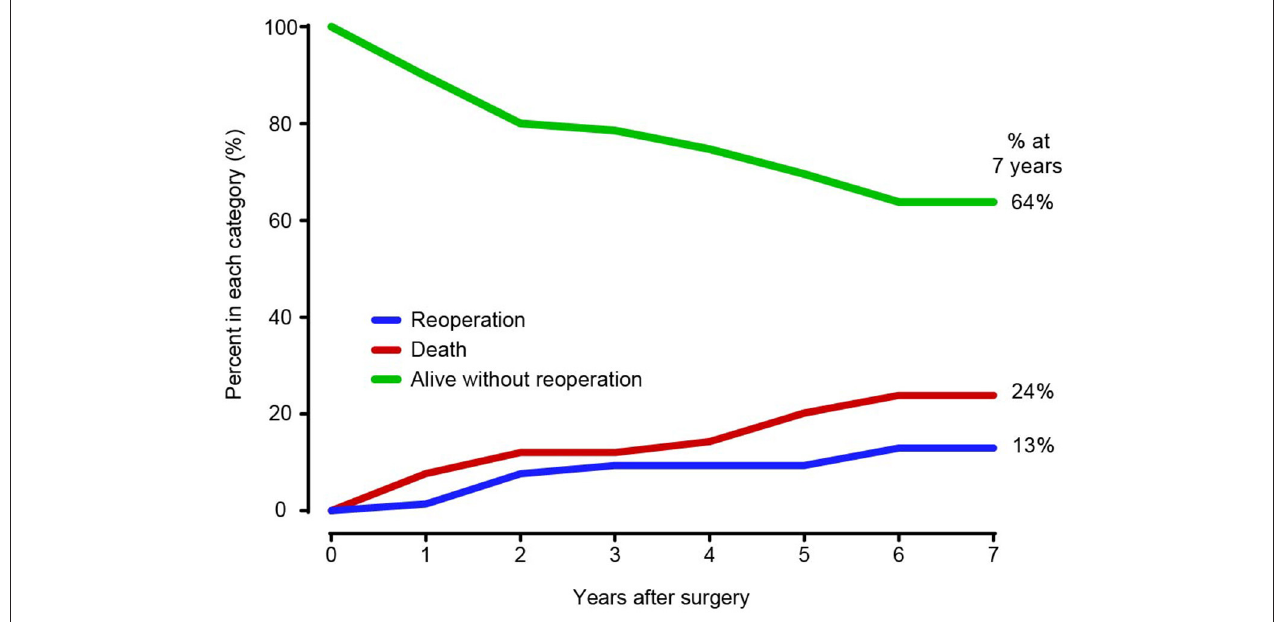
FIGURE 5 | Competing risks of death and distal aortic